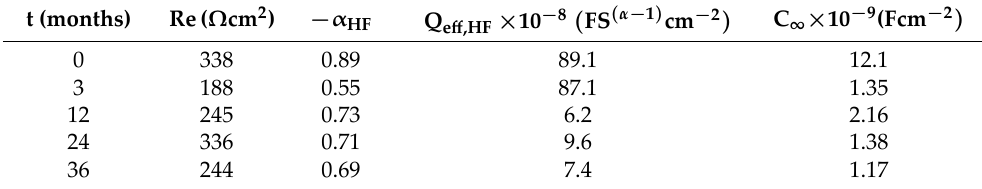
Table 3. Impedance parameters of copper samples at different exposure times.